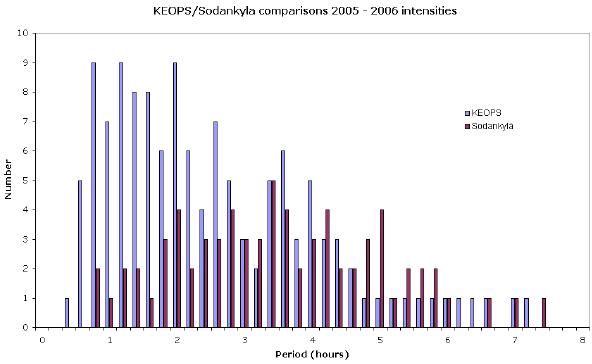
Fig. 6. Comparison of histograms of gravity wave periods for in- tensity data, from KEOPS and Sodankyl¨a over the winter season of 2005–2006.